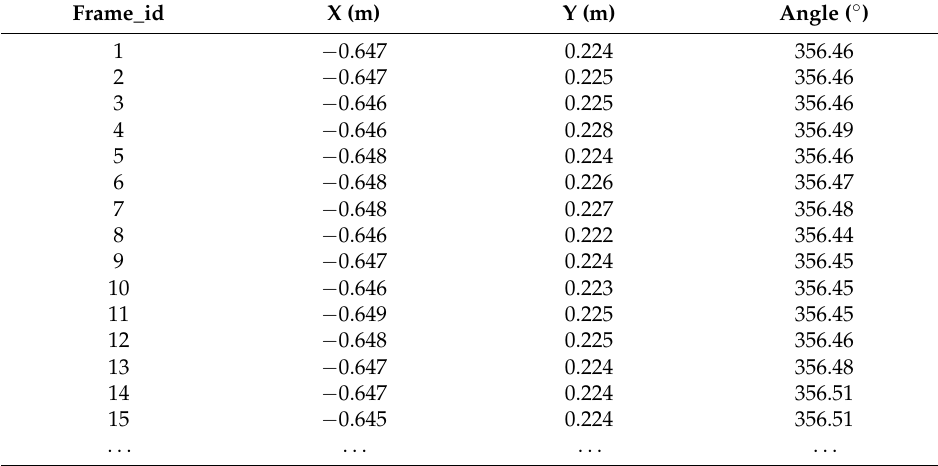
Table 1. Data storage format of NAV350.